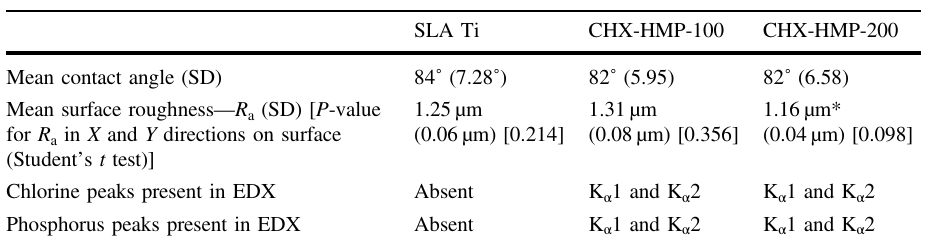
Table 2 Physical and chemical characteristics of SLA Ti and CHX-HMP coatings